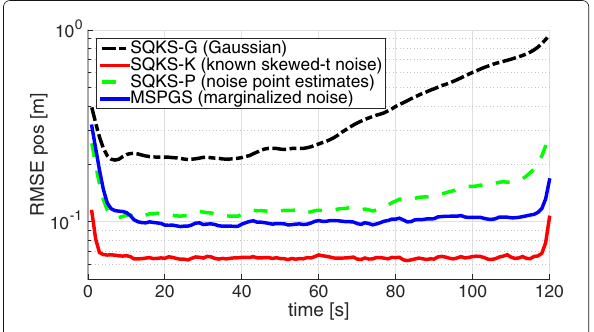
Fig. 2 Smoothing RMSE of position with ν = 4